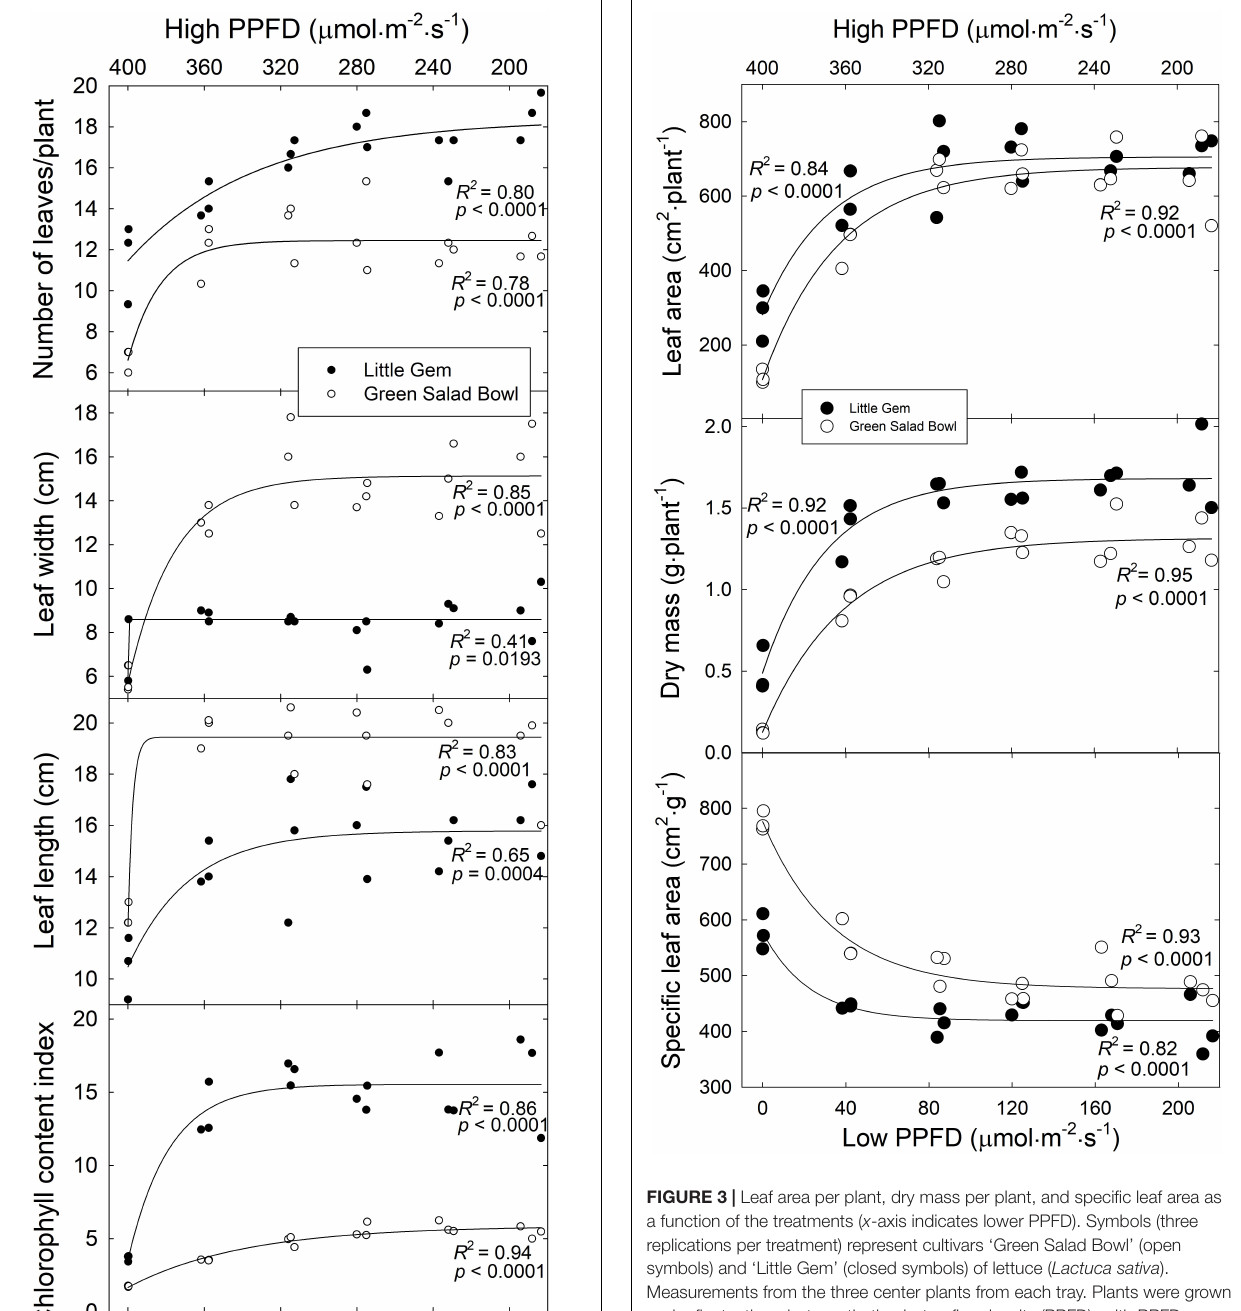
∼ 30% lower leaf area compared to the other treatments ( Figure 3 ). ‘Little Gem’ plants in the 400/0 µ mol · m − 2 · s − 1 and 360/40 µ mol · m − 2 · s − 1 treatments, had a ∼ 70 and ∼ 22% lower dry mass and an ∼ 59 and ∼ 16% lower leaf area compared to the other treatments. ‘Green Salad Bowl’